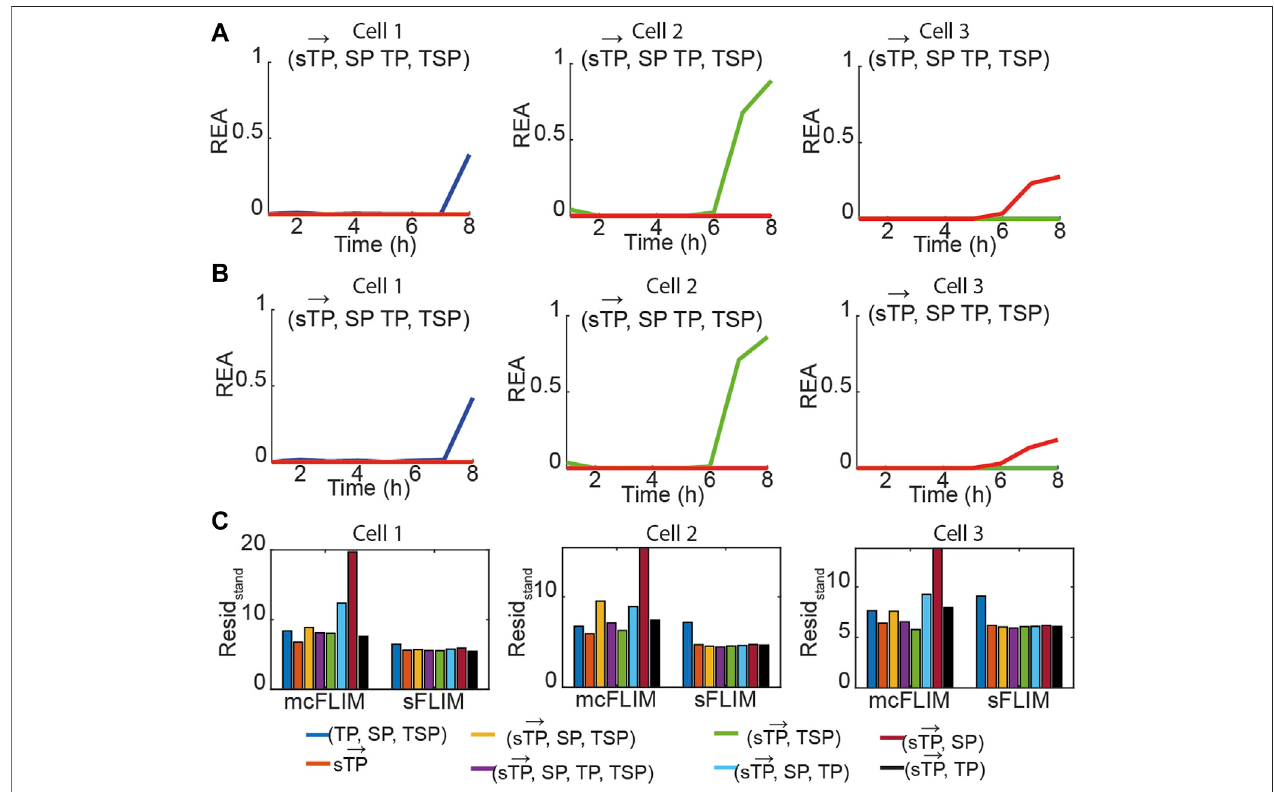
FIGURE 3 | Multiplexing biochemical reactions using multidimensional phasor-based demixing. (A,B) Results of the multidimensional phasor-based demixing of (cid:1)(cid:1)(cid:1) → thetime-lapsedatashownin Figure2 using( sTP , TP , SP ,and TSP )phasorsandpresentedasarelativeenzymaticactivity(REA, top) forsFLIM (A) andmcFLIM (B) .The completesetofresultsforeachalgorithmisshownin SupplementaryFiguresS2,S3 . (C) Themeanstandardizedphasorresidualssummedovertimeforthedemixing of the three cells shown in panels (A,B) and Figure 2 (see Eq. 10 Materials and Methods ).